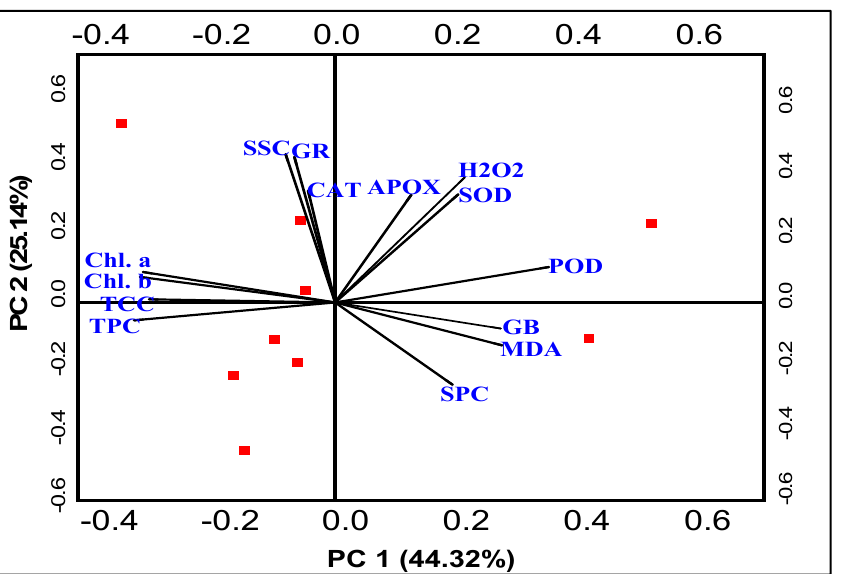
Figure 5. Correlation between various physio-biochemical activities of A. sativa under drought stress conditions.